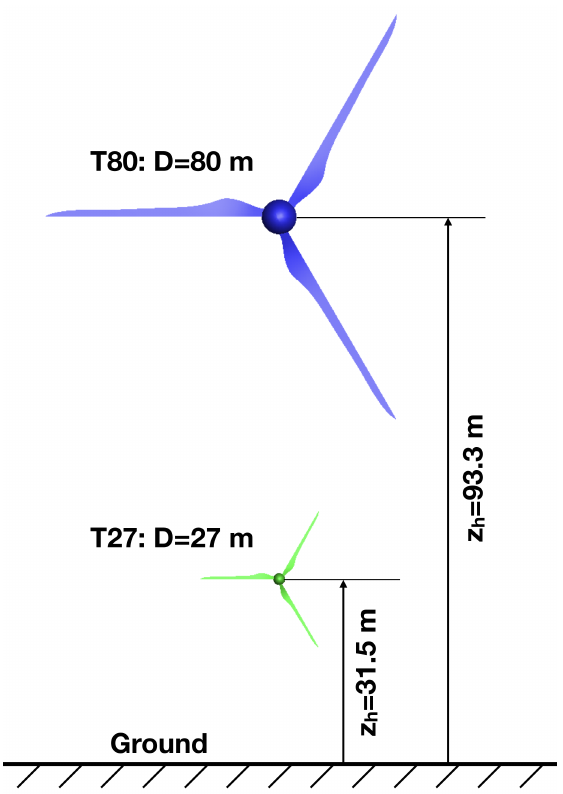
Figure 1. Schematic of the two turbines of different sizes employed in this work. Large blue turbine: T80, diameter D = 80 m, hub height z h = 93.3 m; small green turbine: T27, diameter D = 27 m, hub height z h = 31.5 m.